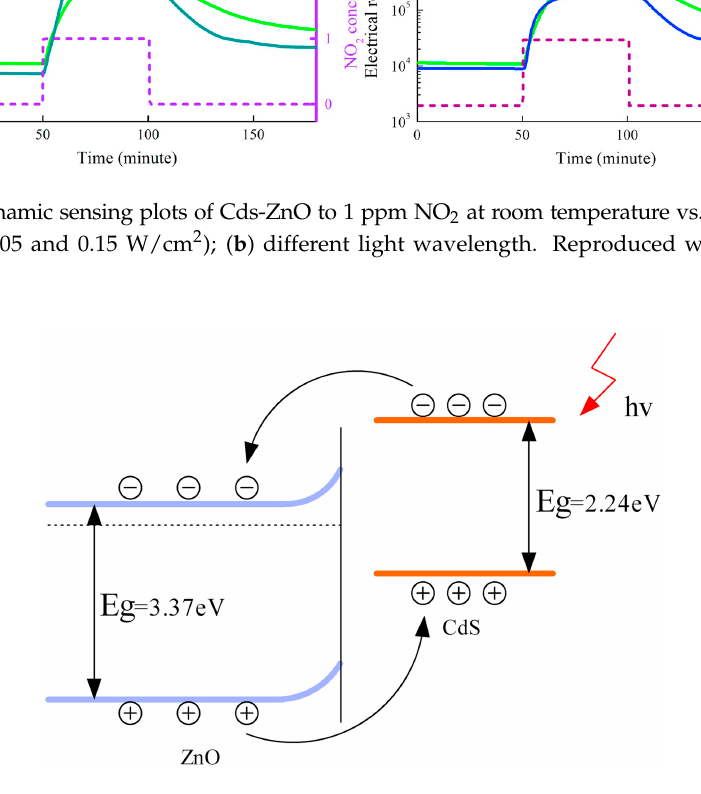
Figure 50. Schematic of carrier transportation in CdS-ZnO under visible light. Reproduced with permission from [73].